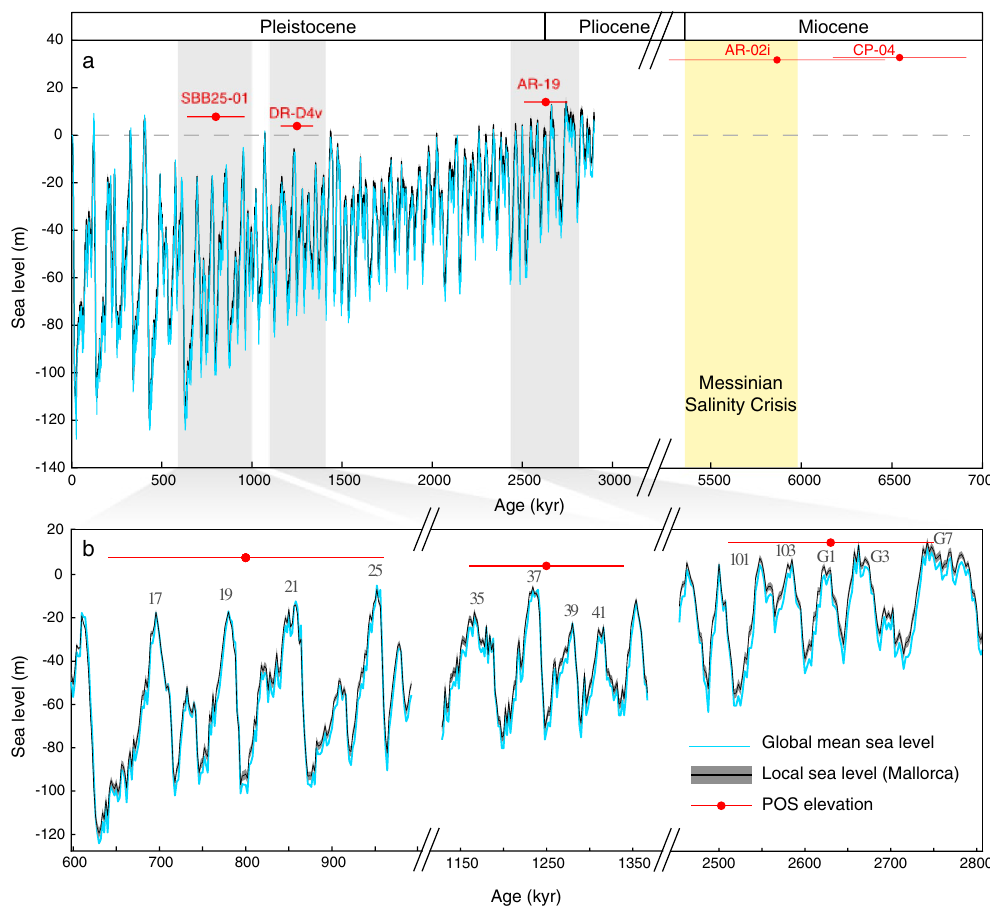
Figure 2. Local sea level at Mallorca. ( a ) Plot shows the whole temporal range. ( b ) Enlarged views for the three most recent data points. GMSL used in the GIA calculation is shown by the cyan line and based on the benthic oxygen isotope stack 20 . The resulting local sea level is shown by the black line. Uncertainty in local sea level that arises from uncertainties in the Earth structure is shown as a gray band around the black line (1σ). Elevation of inferred local sea level for five POS presented here is shown in red, age uncertainties are 2σ. Gray numbers and letters in panel b denote Marine Isotope